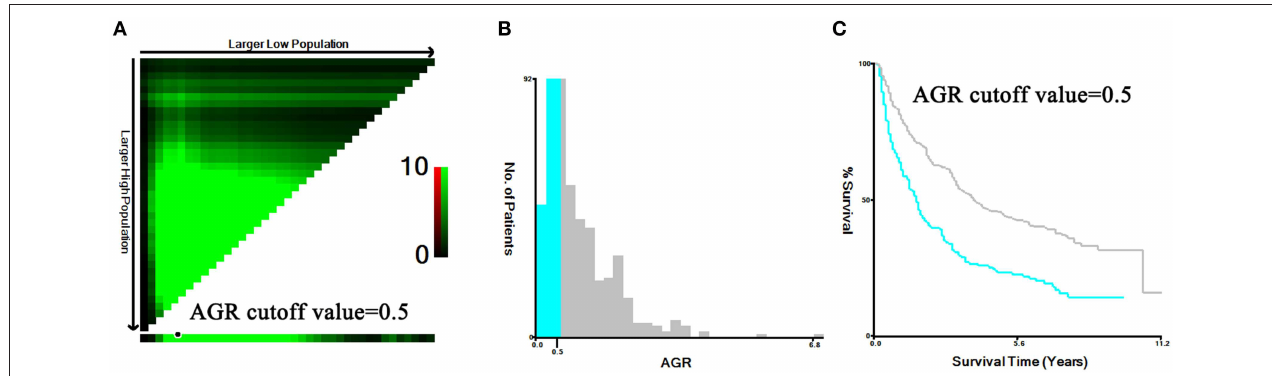
FIGURE 2 | Identification for the cutoff points produced by X-tile plot in the training set. The prognostic power was strongest when the cutoff value of AGR was 0.5 (A–C)